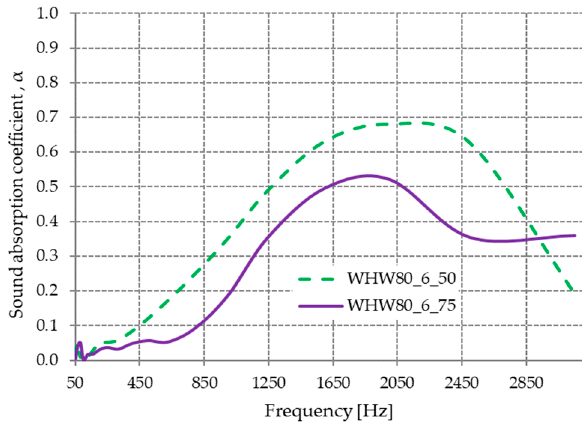
Figure 9. Variation in the acoustic absorption coefficient with the quantity of water.